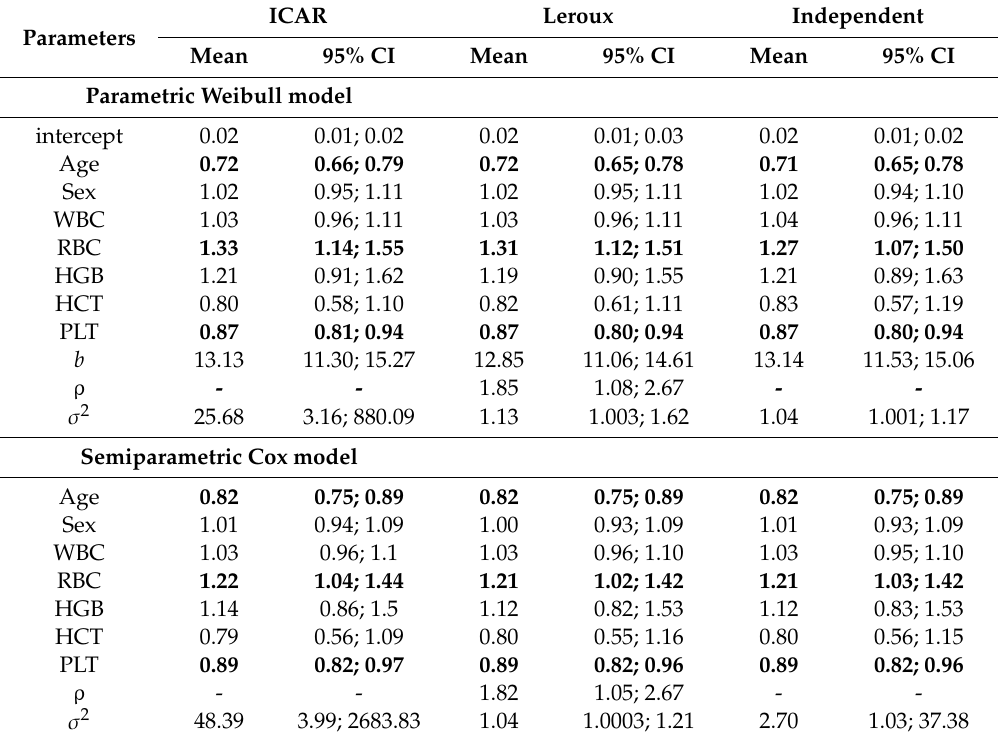
Table 3. Posterior hazard ratios for key parameters of the Weibull and Cox models.